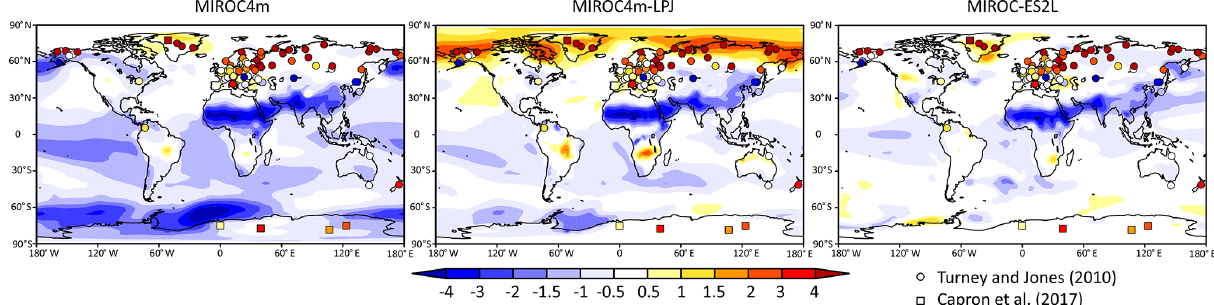
Figure 6. The annual surface air temperature change (K) between 127k and PI is compared with reconstructions by Turney and Jones (2010) and Capron et al. (2017).